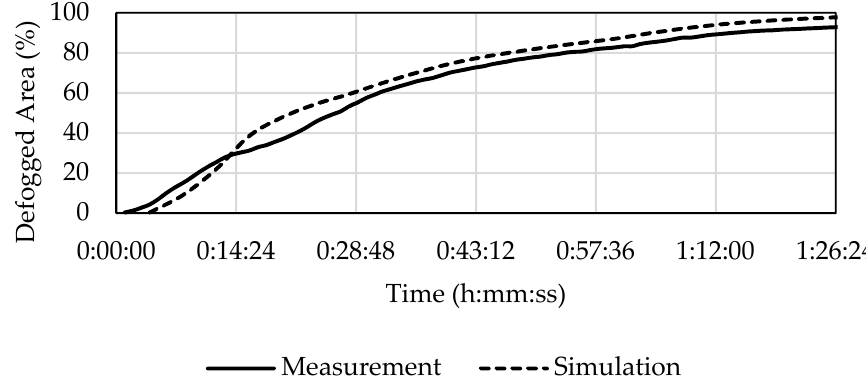
Figure 9. Development of defogging in C1 according to the experiment and the simulation. The measured properties of the ambient air and the air inside the headlamp during the defogging in C1 are shown in Figure 10.